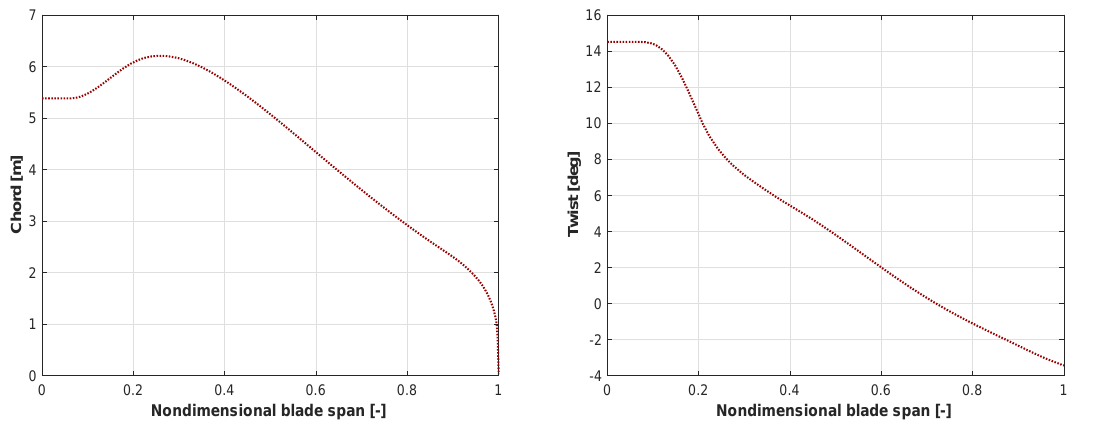
Figure 7. Baseline chord and twist distribution for the 10MW wind turbine blade.